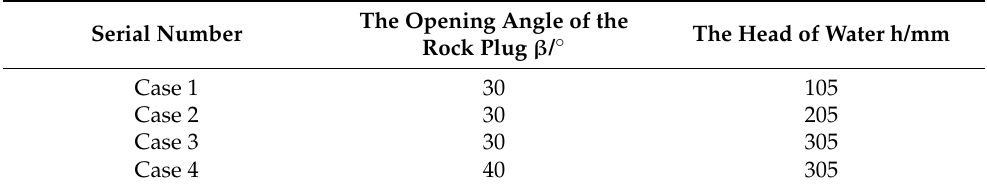
Figure 4. Test system. Table 2. Experimental conditions for underwater rock-plug blasting. Table 2. Experimental conditions for underwater rock-plug blasting.